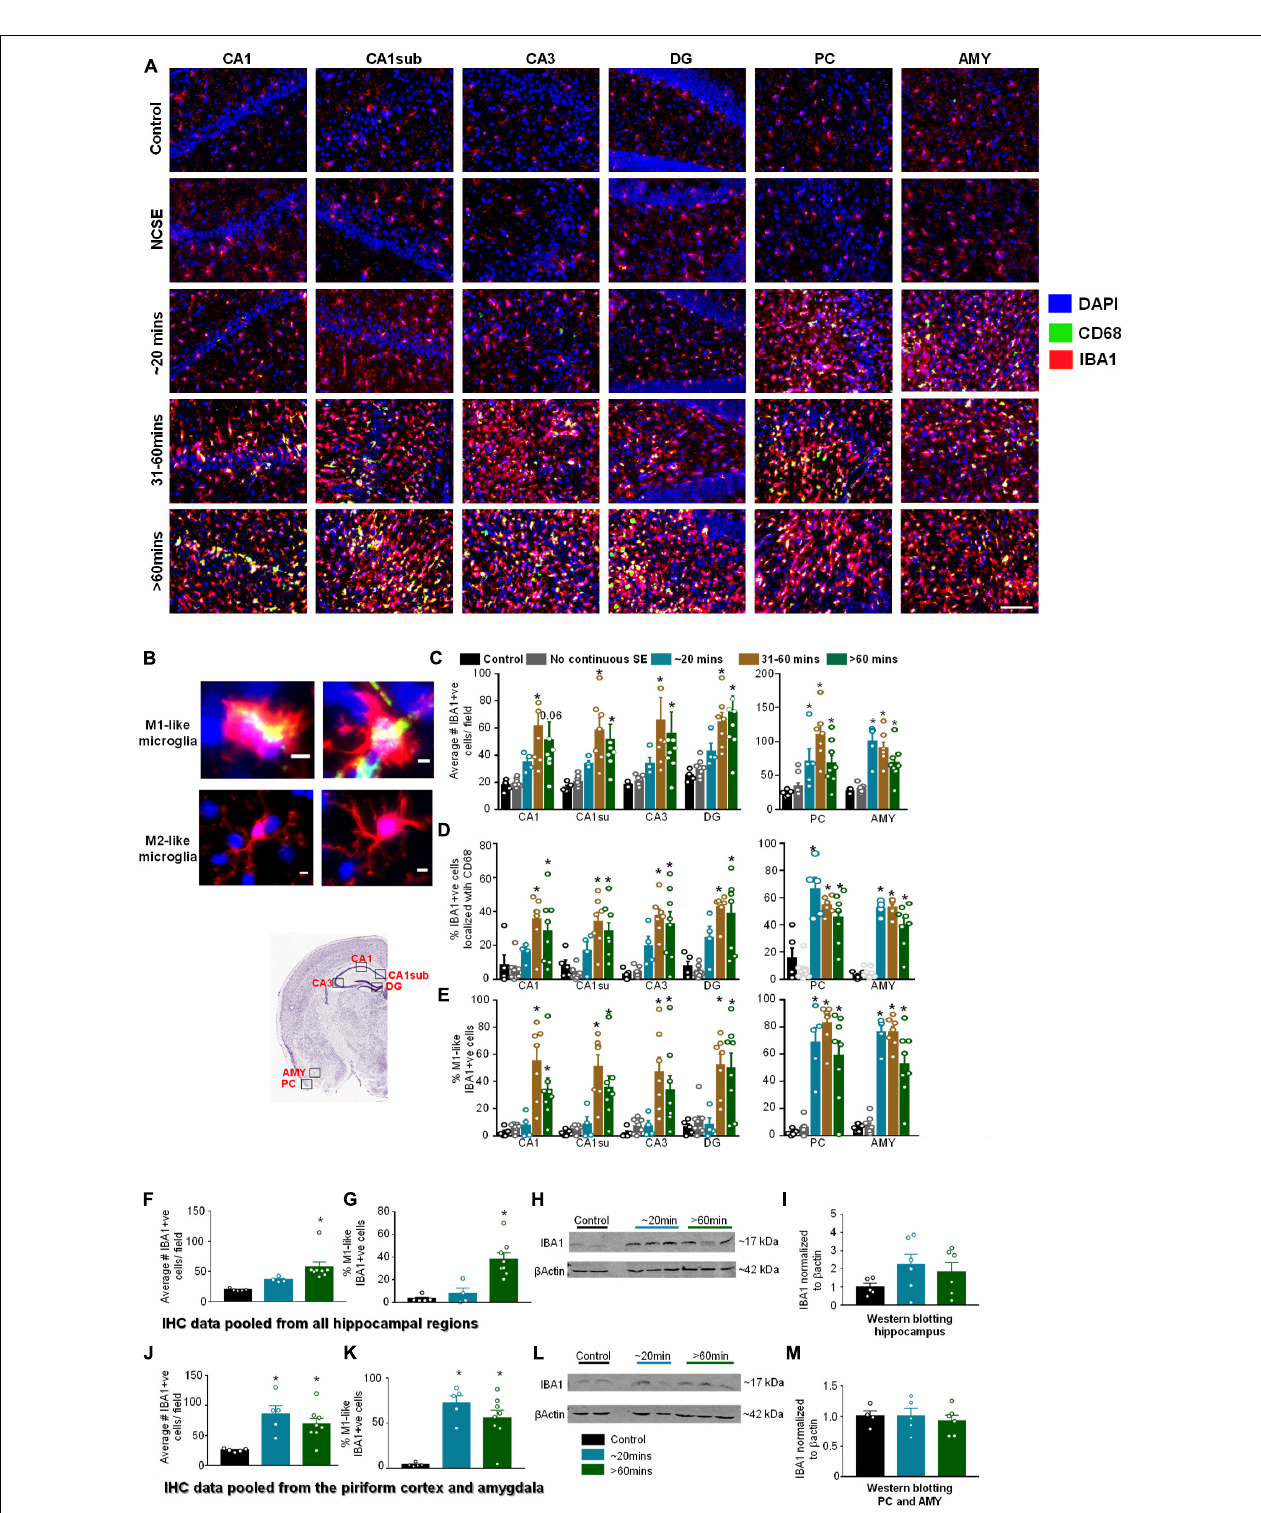
FIGURE 5 | Impact of SE severity and duration on microgliosis. (A) Representative images of the hippocampus (CA1, CA1 close to the subiculum = CA1sub, CA3, DG), piriform cortex (PC) and amygdala (AMY). (B) Examples of reactive (M1-like, large cell body with retracted processes) and non-reactive (M2-like, small cell body with numerous fine branching patterns) IBA1 positive cells. M1-like microglia usually contained CD68 (yellow in the top panels). (C) Average number of IBA1 positive cells, (D) percent IBA1 positive cells colocalized with CD68, (E) percent IBA1 positive cells with reactive (M1)-like morphology (mixed measures ANOVA, n =